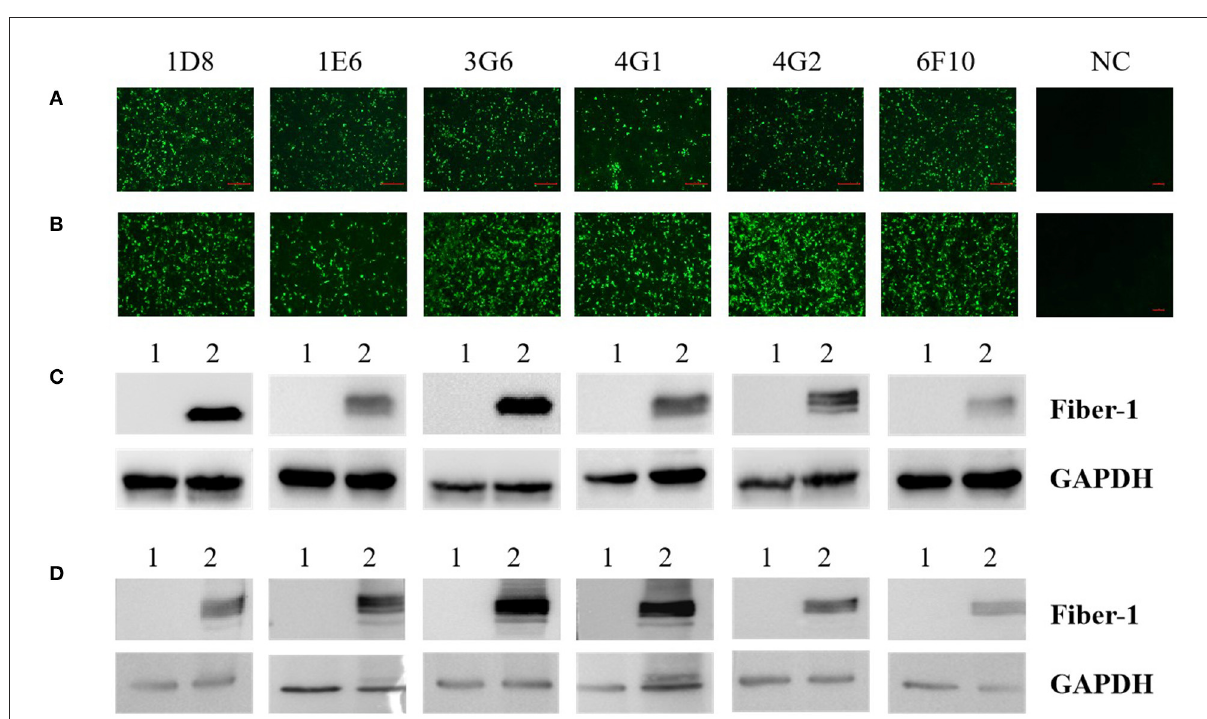
FIGURE2 Characterization analysis of the generated mAbs by IFA and Western blot. (A) The mAbs reacted with LMH cells infected with DAdV-3, but not with mock-infected LMH cells (NC) by IFA. (B) The mAbs reacted with LMH cells transfected with pcDNA3.1-Fiber-1, but not with LMH cells transfected with pcDNA3.1 (NC) by IFA. (C) The mAbs reacted with LMH cells infected with DAdV-3 by Western blot. Lane 1 and 2: LMH cells infected without or with DAdV-3, respectively. (D) The mAbs reacted with LMH cells transfected with pcDNA3.1-Fiber-1 by Western blot. Lane 1 and 2: LMH cells transfected with pcDNA3.1 or pcDNA3.1-Fiber-1, respectively.